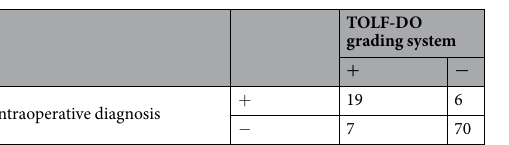
Table 4. The comparison of diagnostic outcomes in TOLF-DO grading system and Intraoperative diagnosis. Sensitivity = 19/25 * 100% = 76.0%. Specificity = 70/77 * 100% = 91.0%. Positive predictive value = 19/26 * 100% = 73.1%. Negative predictive value = 70/76 * 100% = 92.1%.